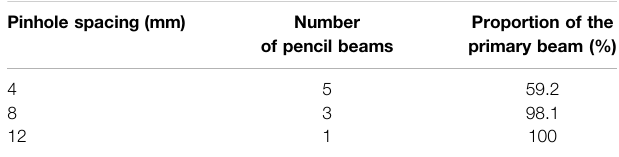
TABLE 1 | Collimation results with different pinhole spacing. Pinhole spacing